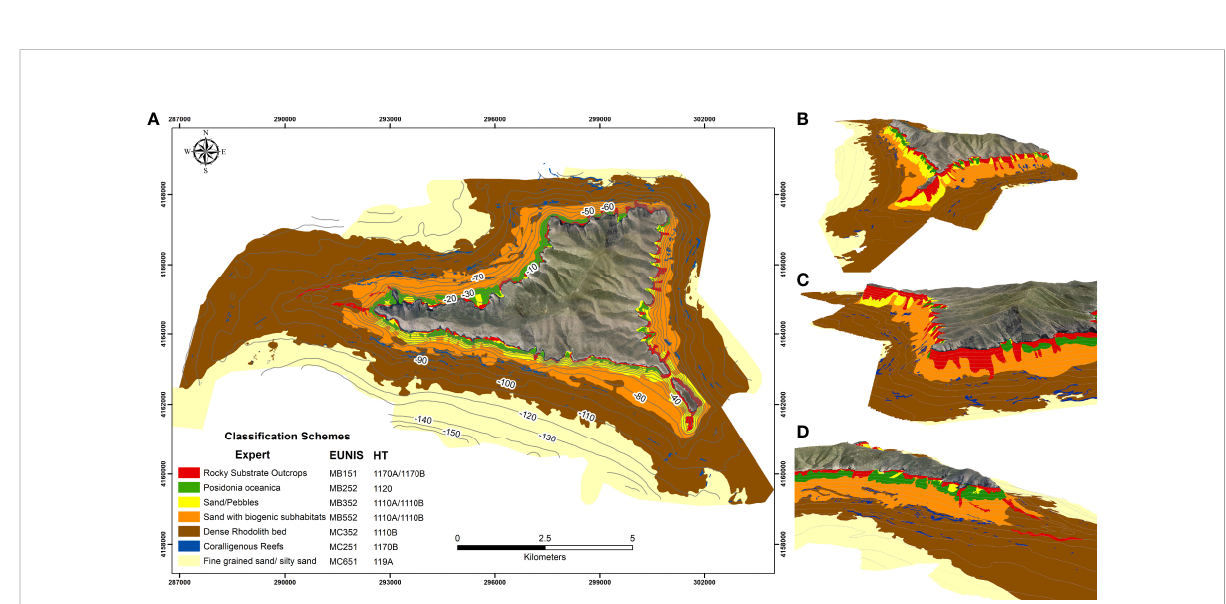
FIGURE 8 The classi fi cation map (A) of Gyaros sea fl oor and three-dimensional images (B – D) depicting the zonal distribution of the classes based on